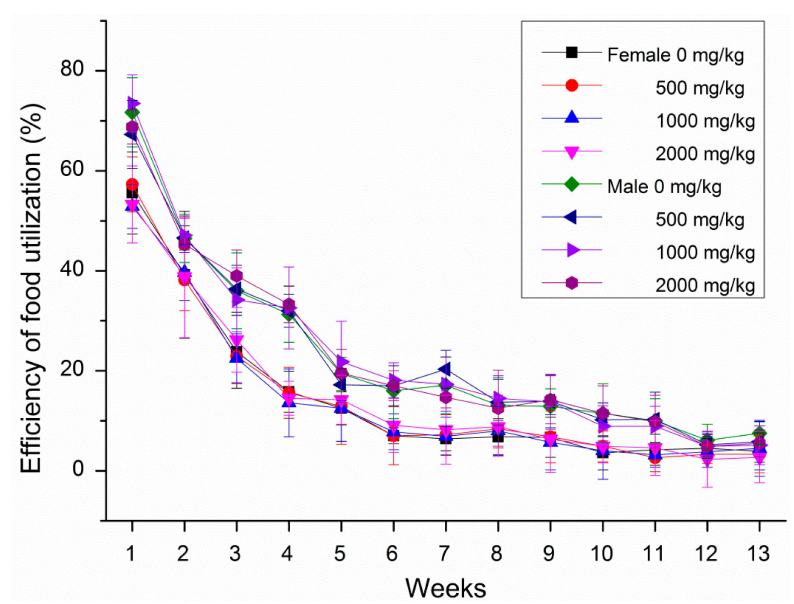
Figure 6. Efficiency of food utilization per week of rats treated with GBP for 91